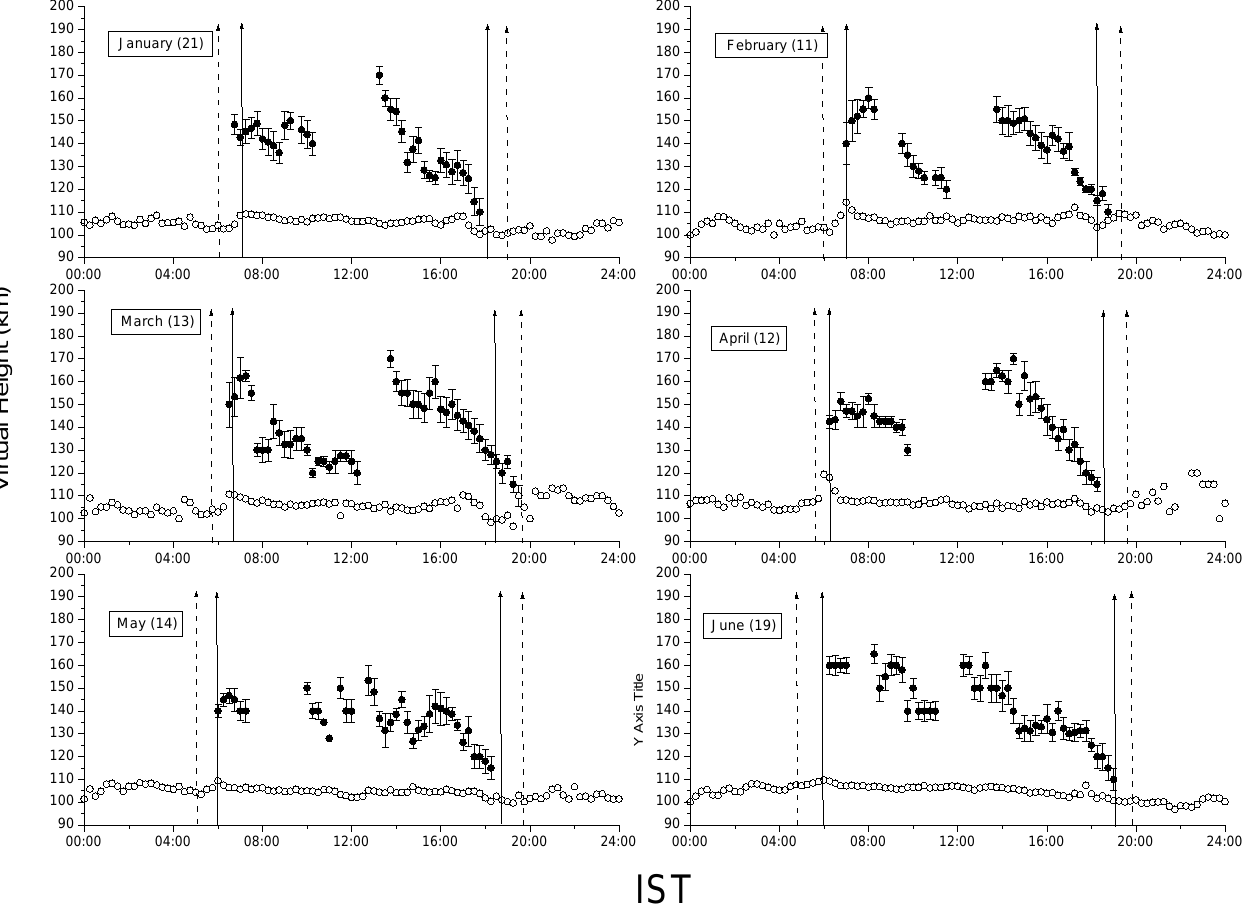
Fig. 4a. Monthly mean variation of the virtual height of descending intermediate layer (solid dots) Es along with constant height Es (open circles) for January to June 2004 at a sub-tropical station Waltair. The error bars indicate the standard deviation of the mean. The vertical solid lines indicate the sunrise and sunset times at ground level and the dashed lines indicate those at an altitude of